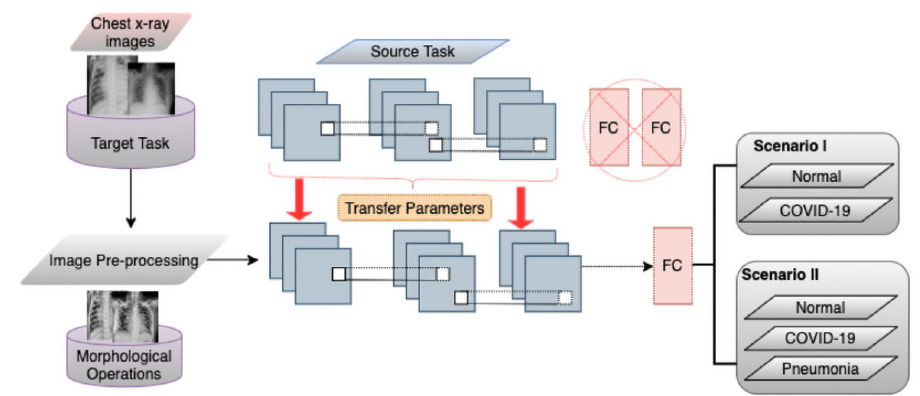
Fig 5. Proposed pre-trained method for COVID-19 detection.